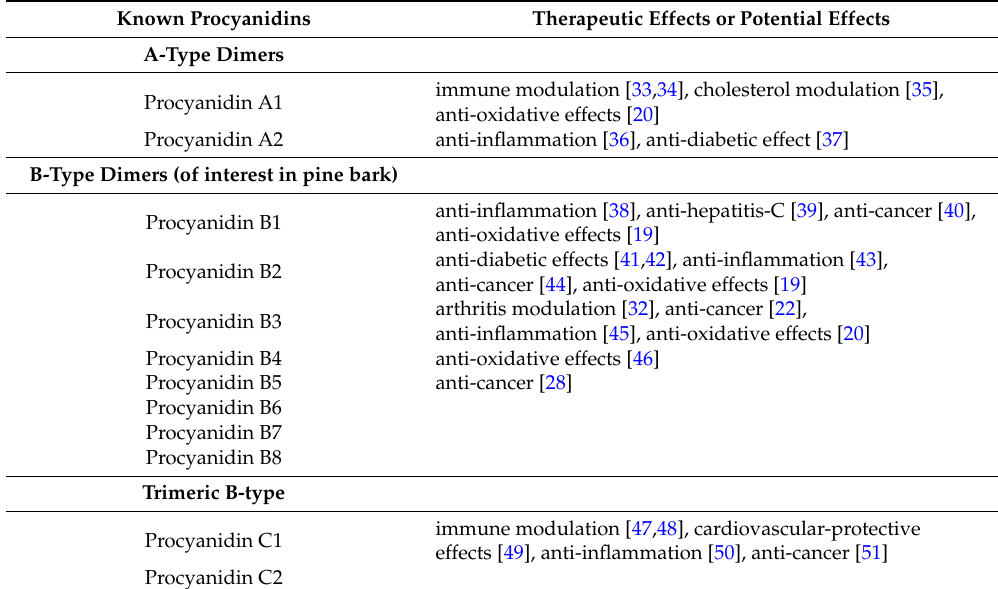
Table 1. Composition of procyanidins and their therapeutic effects or potential